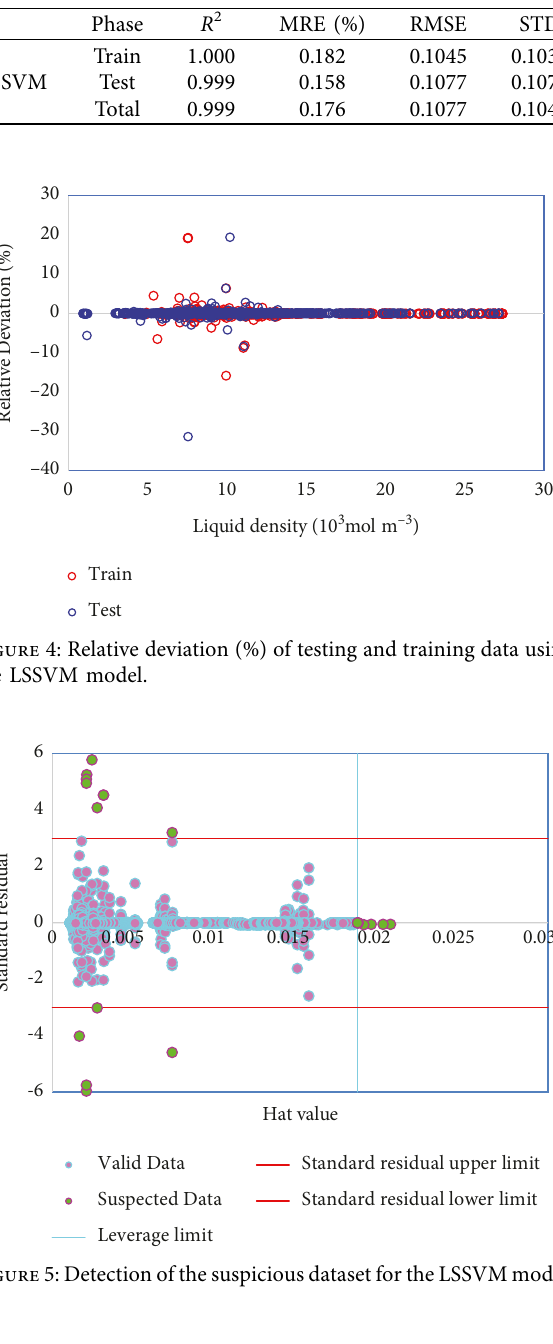
Table 1: Evaluating the performance of the proposed model using statistical analysis.